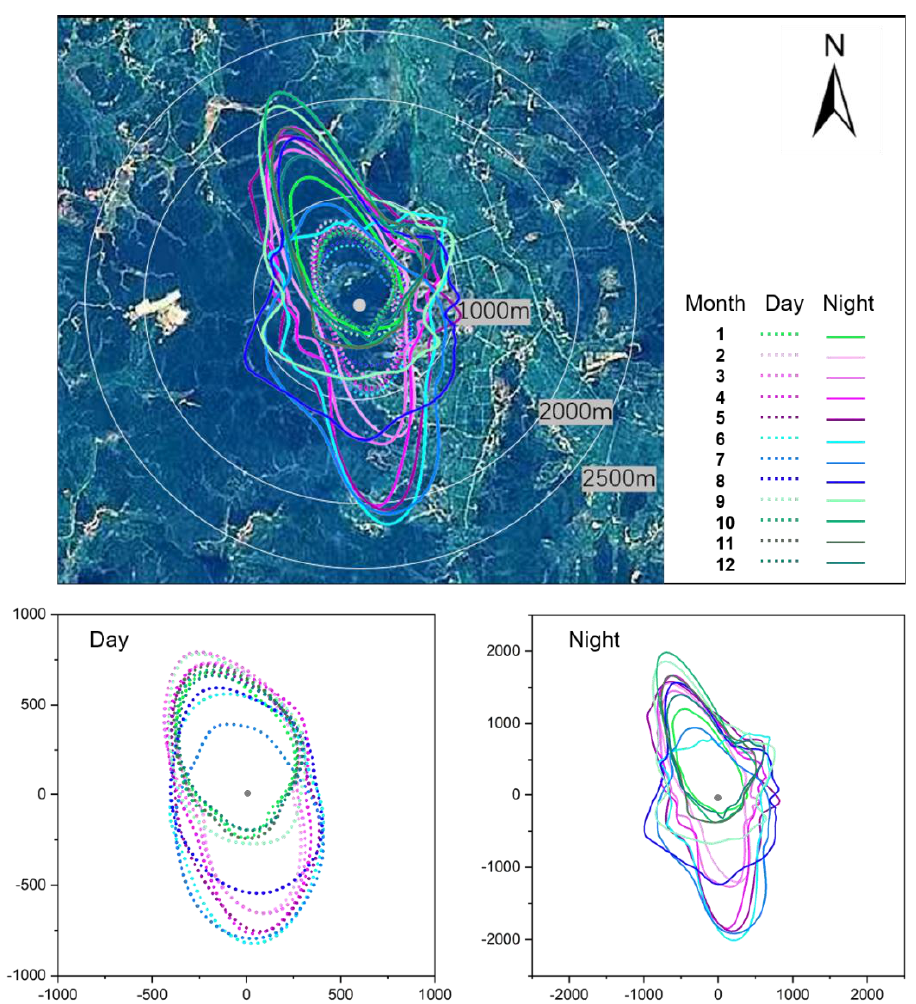
Figure 1. The 80% monthly footprint climatologies in daytime and nighttime were calculated from 2003 to 2010 over the study area.